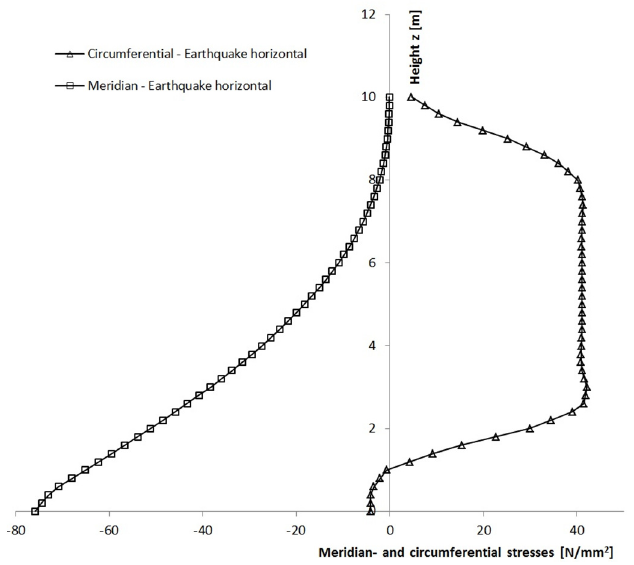
Figure 10. Circumferential and axial stresses due to horizontal seismic excitation.